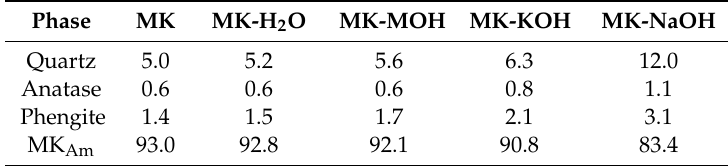
Table 5. Results of QPXRD in wt%. The absolute error is ± 0.5 wt.% for the crystalline phases and ± 1 wt.% for MK AM.